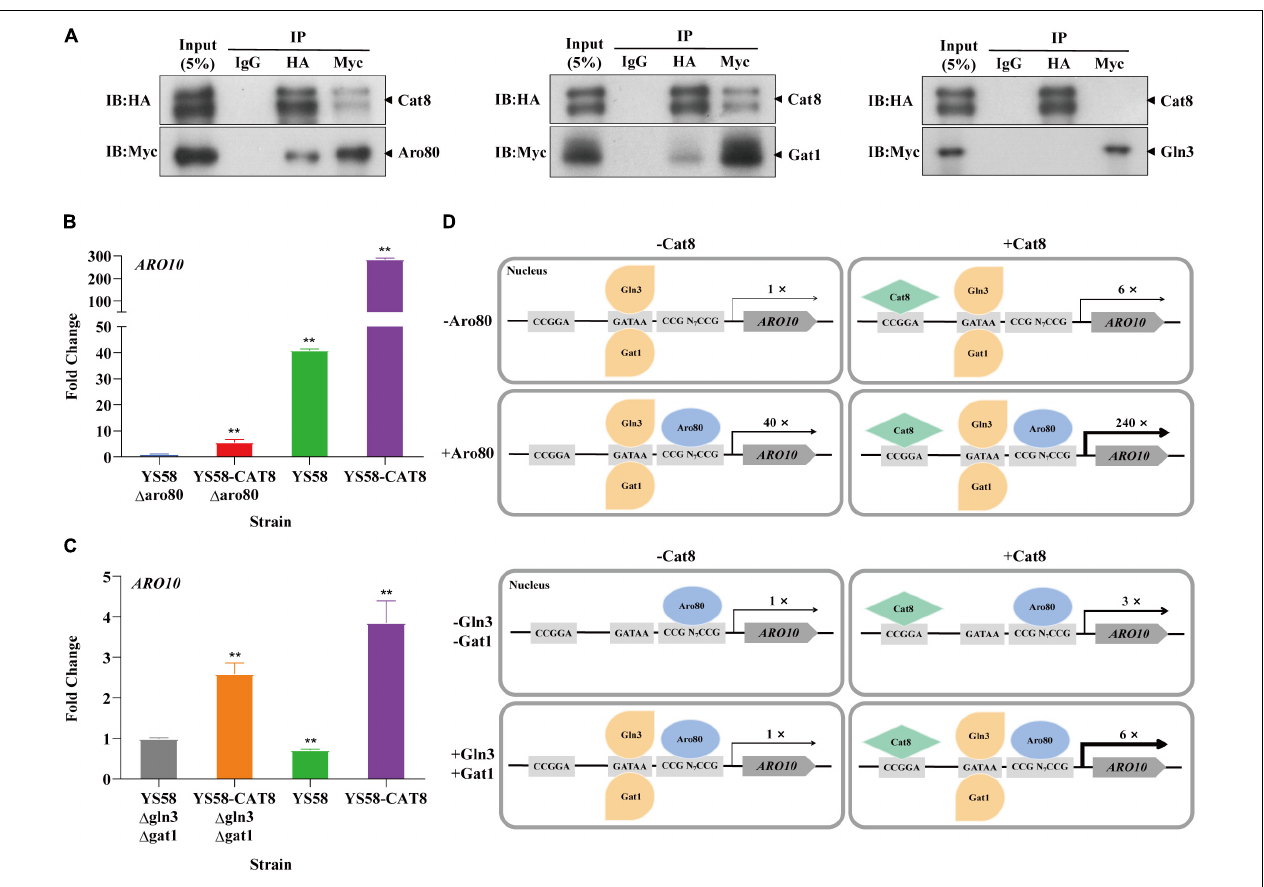
FIGURE 5 | The interaction of Cat8 with Aro80 and GATA activating factors. (A) The Co-immunoprecipitation of total protein extracted from strains YS58-CAT8-HA Aro80-Myc, YS58-CAT8-HA Gat1-Myc, and YS58-CAT8-HA Gln3-Myc from left to right. Input (5%) was used as a positive control and IgG as a negative control. Immunoprecipitated proteins (IPs) were analyzed by immunoblotting and probing with HA and Myc antibodies. (B) Effect of Aro80 on the ARO10 transcription level of wild-type strain and CAT8 overexpression strain. (C) Effect of GATA factors on the ARO10 transcription level of wild-type strain and CAT8 overexpression strain. (D) The interaction pattern of Cat8 with Aro80 and GATA activator factors. Yeast cells were cultivated in fermentation medium with glycerol as the only carbon source for 6 h. ACT1 was used as the reference gene, and wild-type strains with ARO80 or GLN3 / GAT1 deletion were used as controls. Data shown are mean values ± SDs of triplicates. Statistical difference between strains was determined by two-tailed Student’s t -test, ** p <